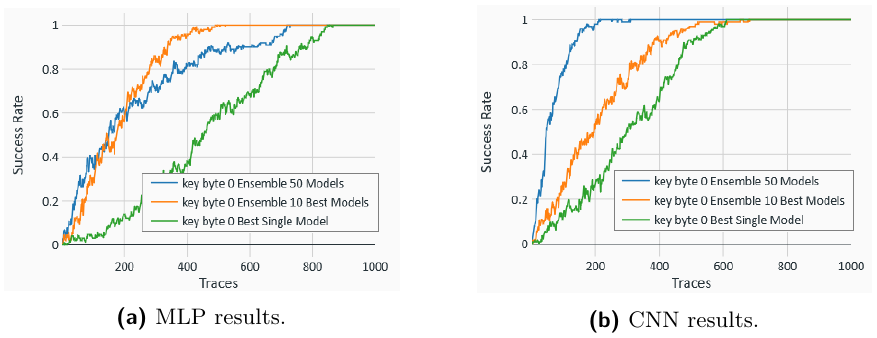
Figure 15: Success rate for CHES CTF 2018 for the Hamming weight leakage